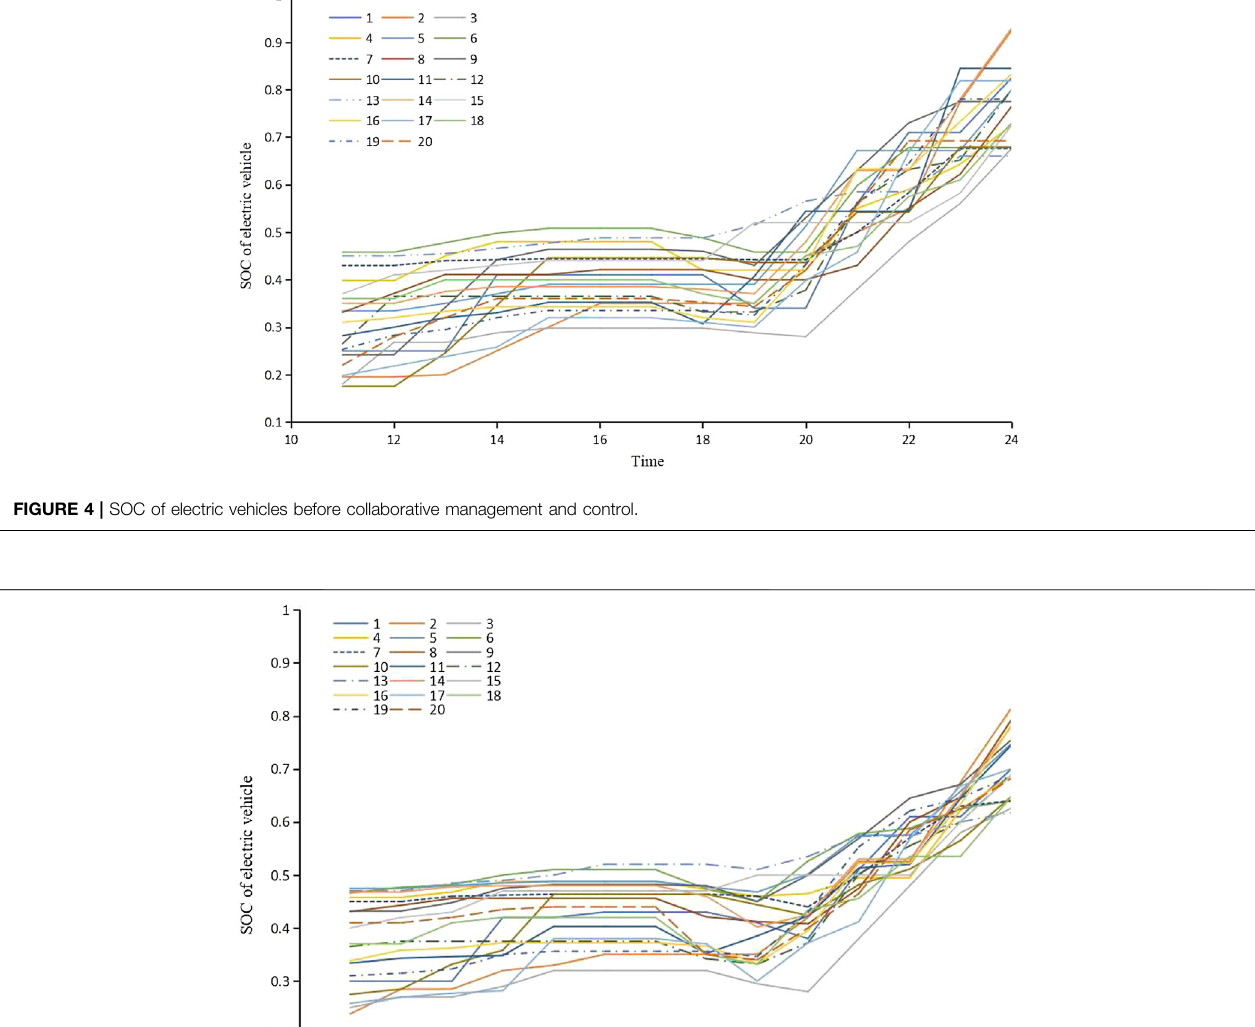
Figure 2 . The EV parameters of households are shown in Table 1 .